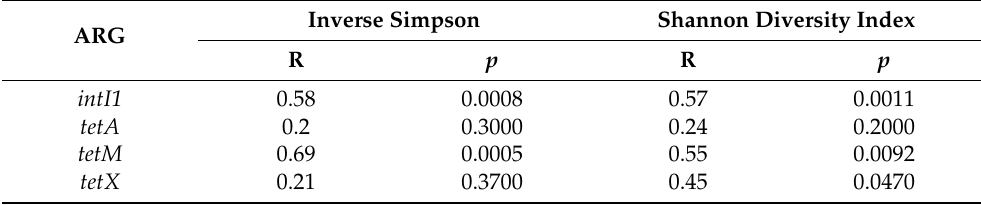
Table 3. Associations between antimicrobial resistance gene (ARG) abundance and alpha diversity measures in the distal gut microbiome of Nile tilapia. Inverse Simpson Shannon Diversity Index ARG R p R